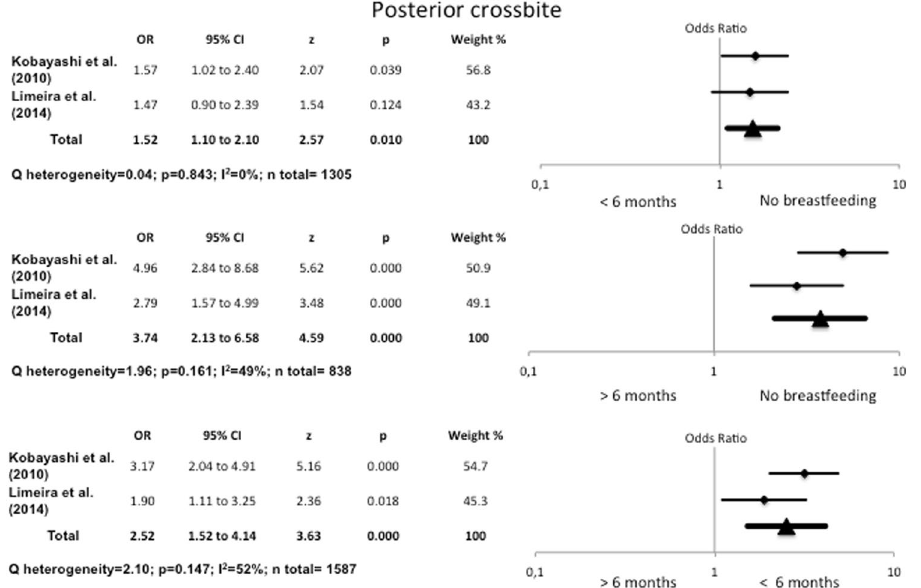
Figure 3. Odds Ratio for posterior crossbite, comparing no breastfeeding with exclusive breastfeeding for < 6 months and > 6 months, and < 6 months of exclusive breastfeeding with > 6 months.